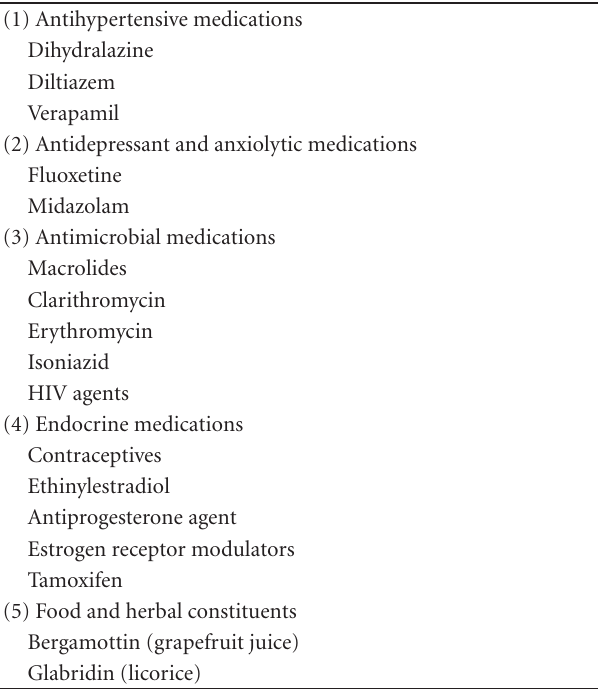
Table 3: Inhibitors of